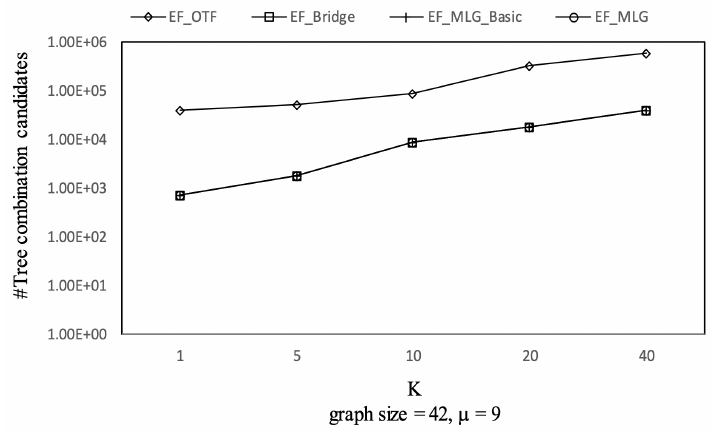
Figure 13. Tree combination pruning on GraphGen vs. k with graphsize = 42 and µ = 9.